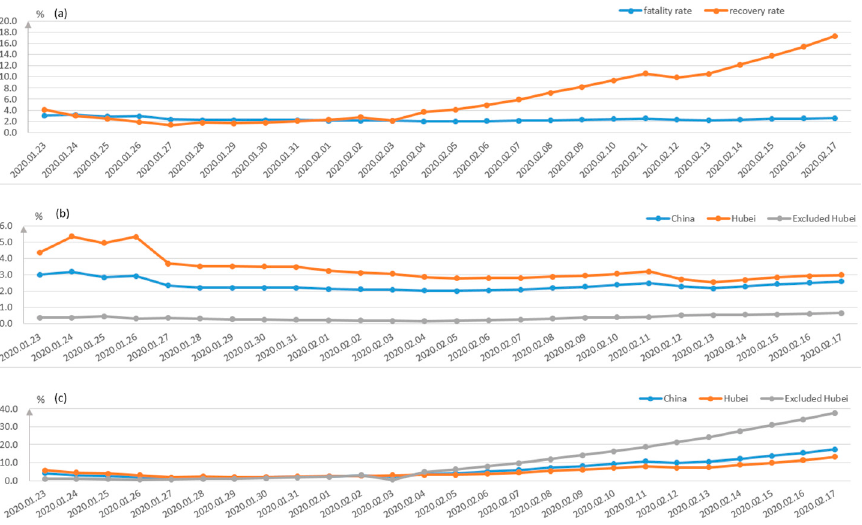
Figure 4. Fatality and recovery rates in different regions. ( a ) shows the comparison between the death rate and recovery rate in China, while ( b , c ) show the death rates and the recovery rates of China, Hubei and non-Hubei provinces, respectively.